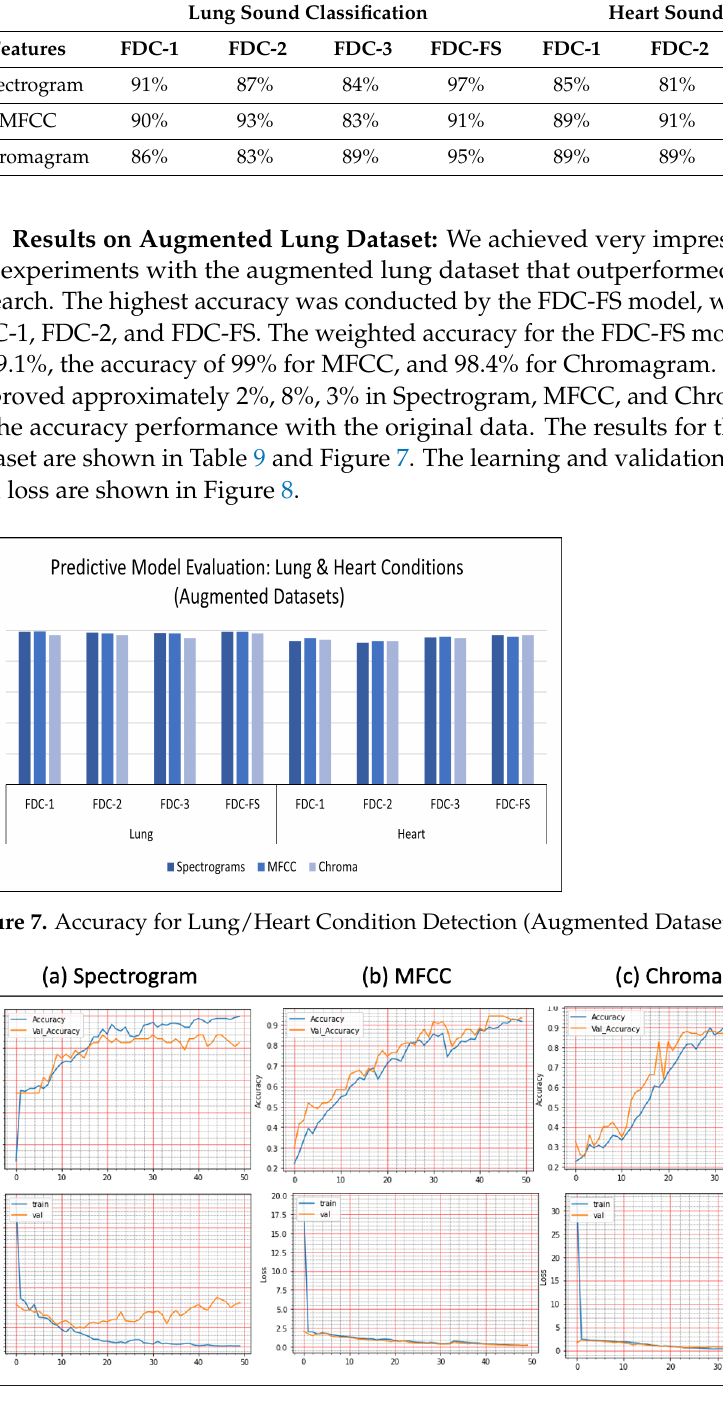
Figure 8. Lung Condition Classification (Accuracy vs. Loss): The Fusion Network Model (FDC-FS) was Evaluated with Three Features: ( a ) Spectrogram, ( b ) MFCC, ( c )